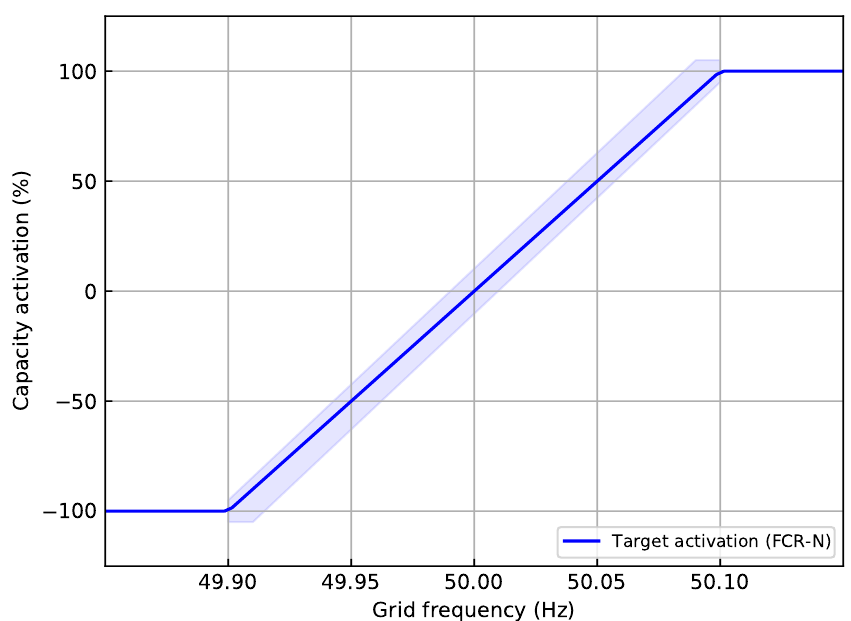
Figure 1. FCR-N stationary performance requirement (adapted from